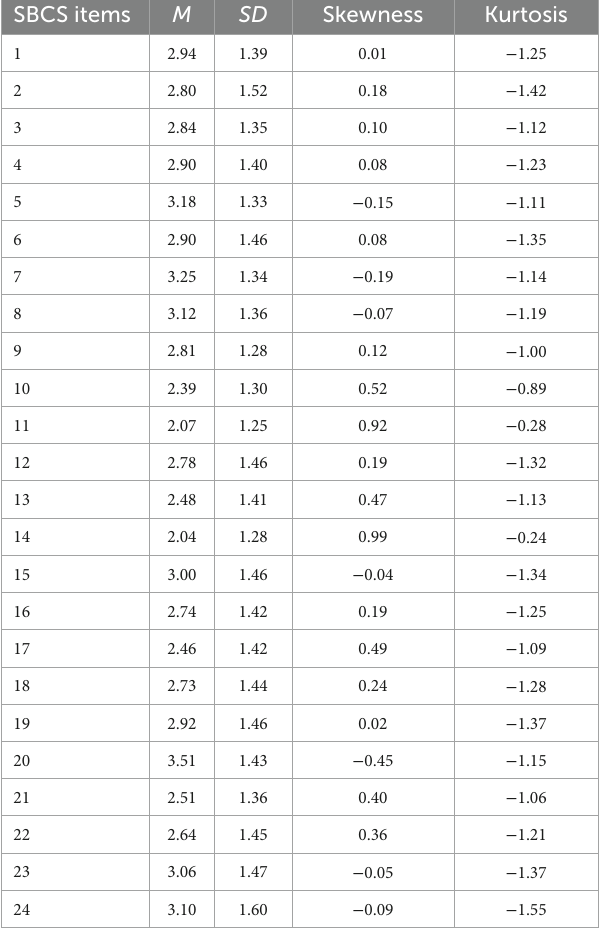
TABLE 3 Mean (M), standard deviation (SD), and skewness and kurtosis for items of the SBCS. SBCS items M SD Skewness Kurtosis